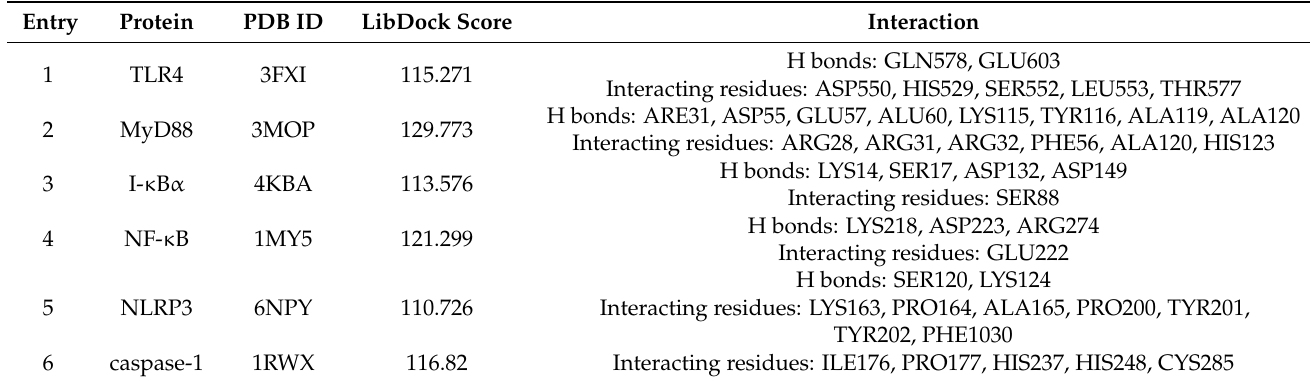
Table 2. Interactions between Gyp I and target